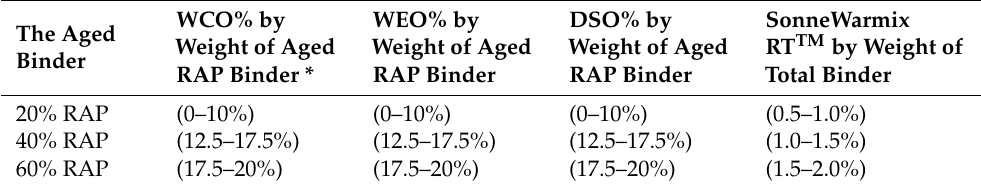
Figure 7. Viscosity–temperature logarithmic chart of virgin